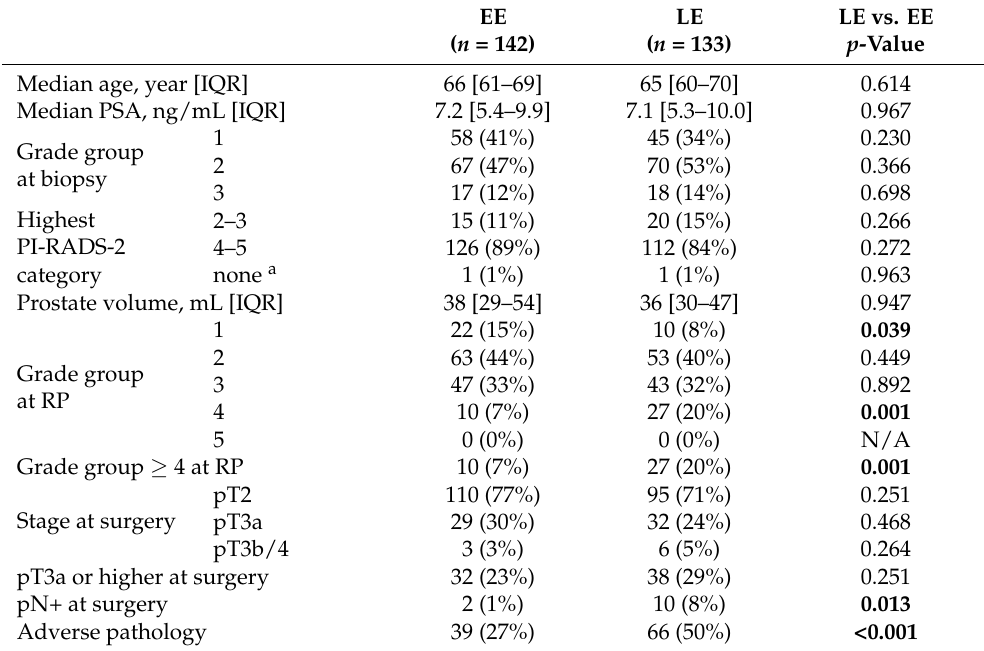
Table 2. The comparison of patient groups limited to non-high risk patients only.